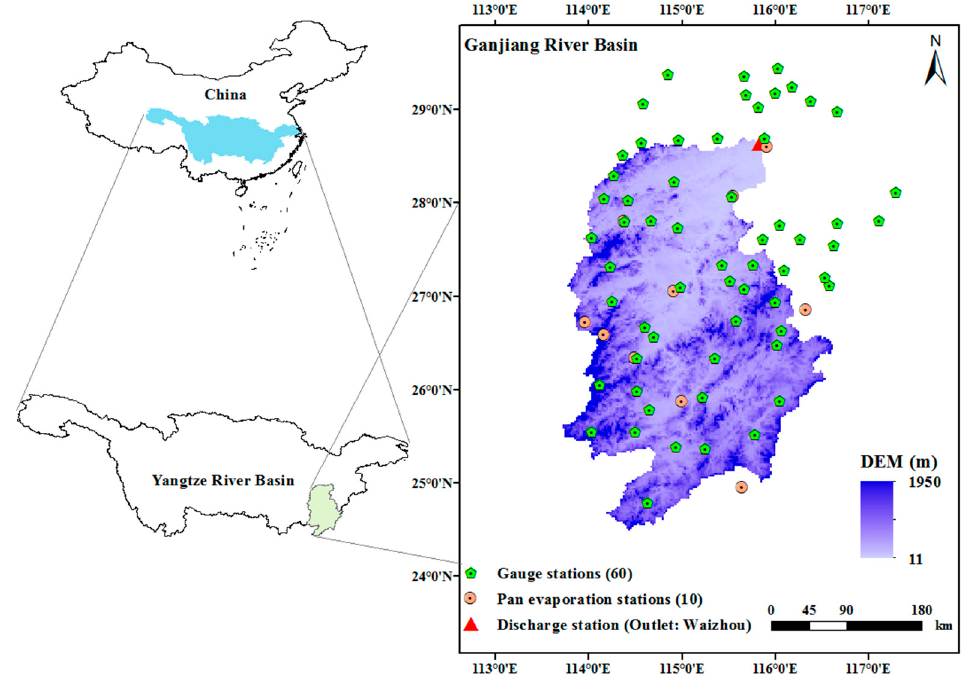
Figure 1. Geographical location, topography, rainfall gauges, pan evaporation stations and discharge station of the study area.